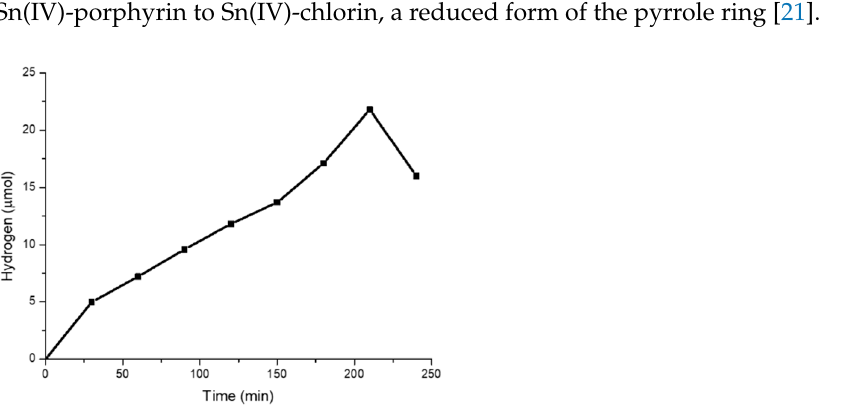
Figure 4. TGA thermogram of SnP 6+ -embedded Nafion/Pt-TiO 2 ( 3 ).